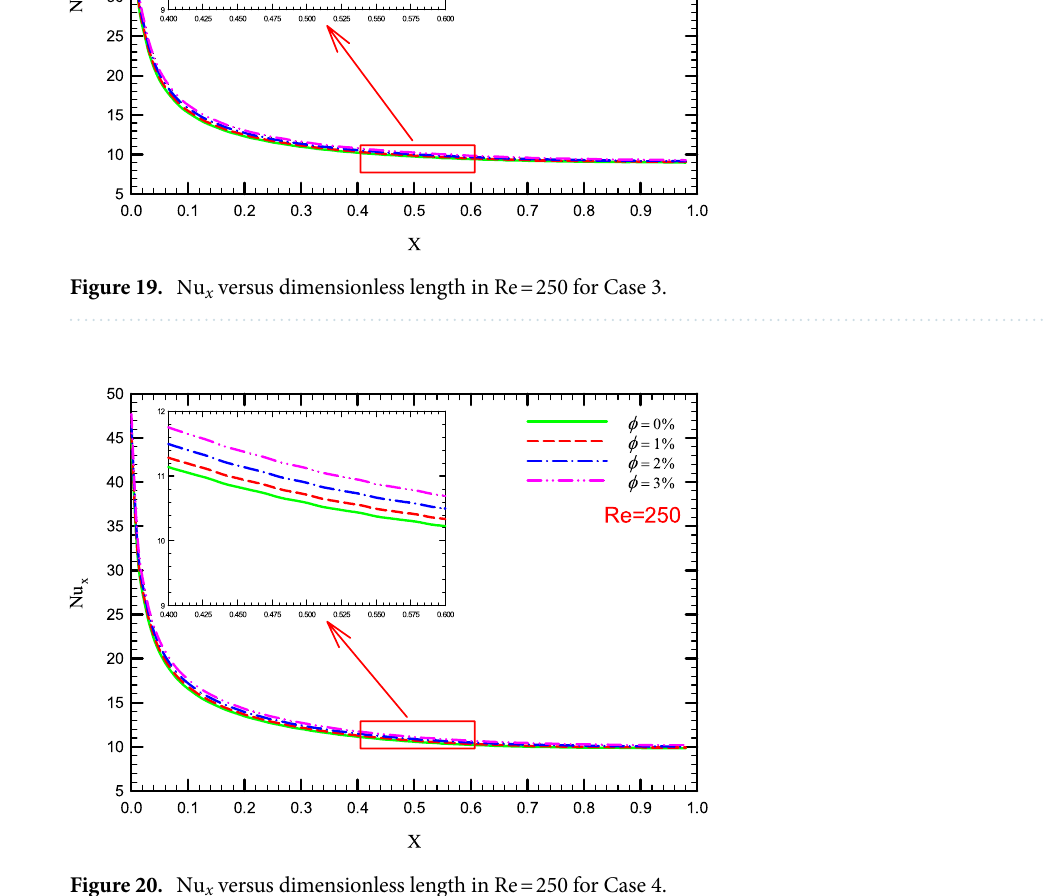
Figure 20. Nu x versus dimensionless length in Re = 250 for Case